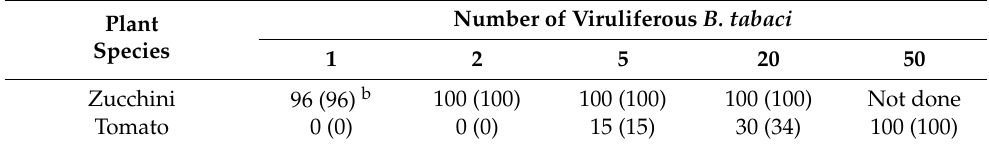
Table 1. Transmission efficiency of ToLCNDV-ES to zucchini and tomato by B. tabaci a .